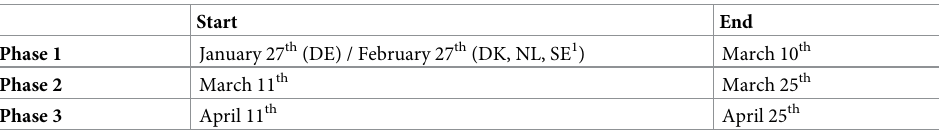
Table 1. Data collection